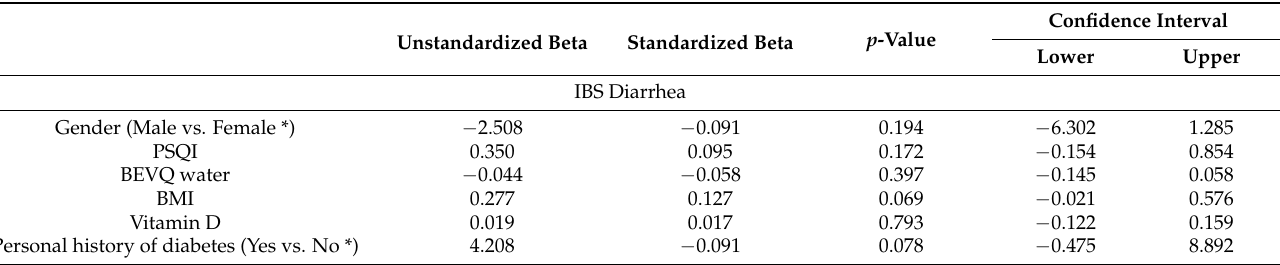
Table 4. Cont. Unstandardized Beta Standardized Beta p -Value